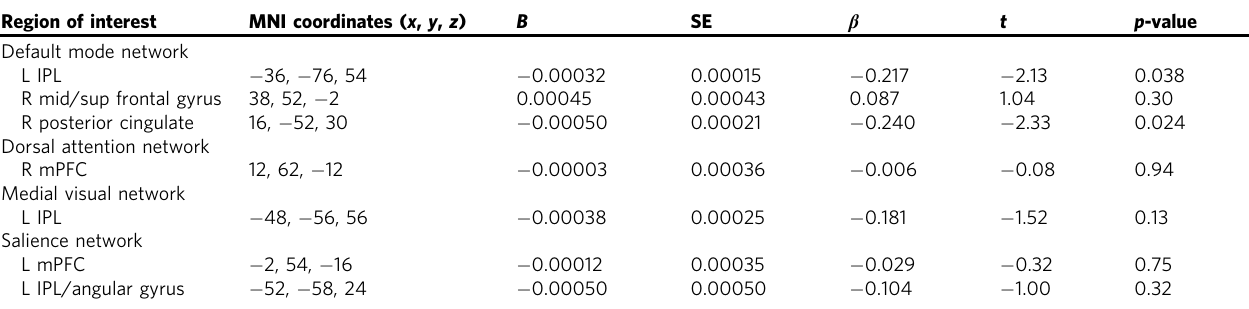
Table 4 Region-of-interest-based analyses of grey matter volume using voxel-based morphometry Region of interest